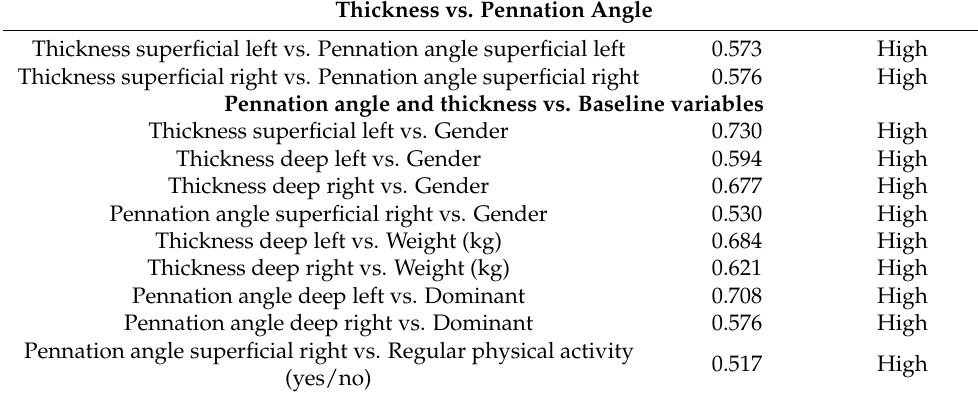
Table 4. Pairwise correlation coefficient results. Thickness vs. Pennation Angle